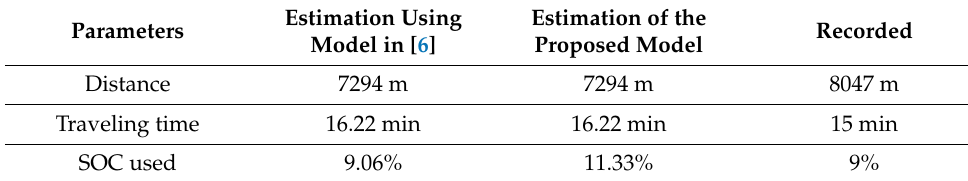
Table 4. The comparison of the estimated data with the recorded data.